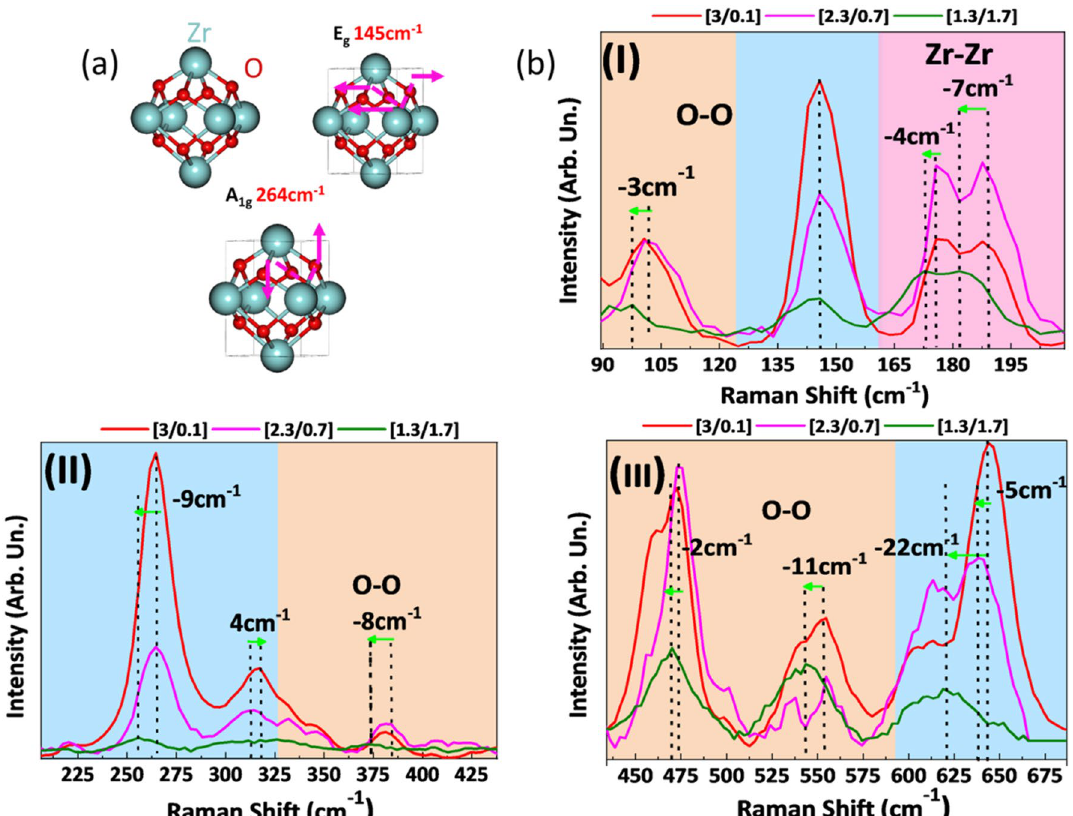
Figure 4. ( a ) Unit cell of ZrO 2 with two indicative t-ZrO 2 lattice vibrations and ( b ) Raman downshifts in reduced ZrO 2−x